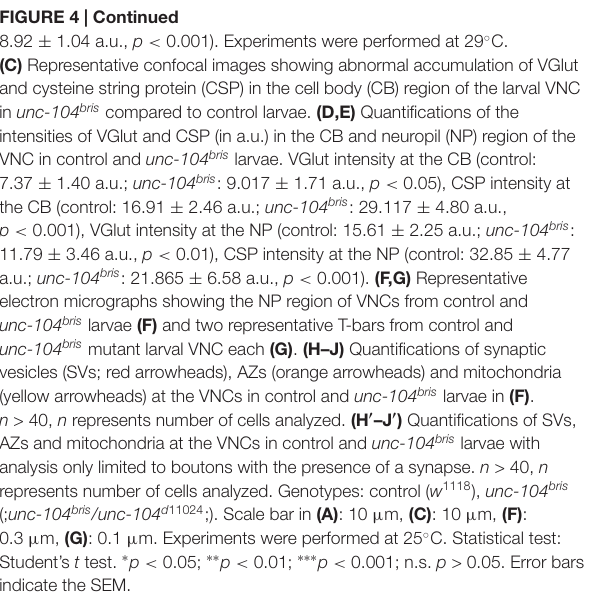
cysteine string protein (CSP) in another model, synapses in the larval NP (Zinsmaier et al., 1990, 1994). Indeed, the levels of VGlut and CSP at the NP region of the VNC were also reduced in unc-104 bris mutants ( Figures 4C,E ), indicating that the number of SVs is reduced at these synapses. Reminiscent VNC in unc-104 bris mutants (Kern et al., 2013), VGlut and CSP